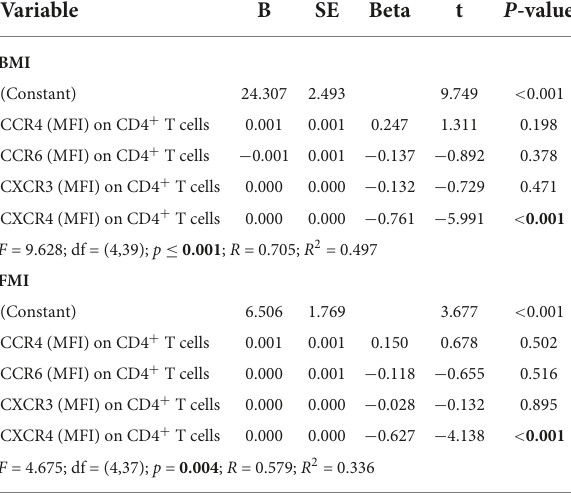
TABLE 5 Multivariate linear regression analyses of BMI, FMI, and chemokine receptor expression.